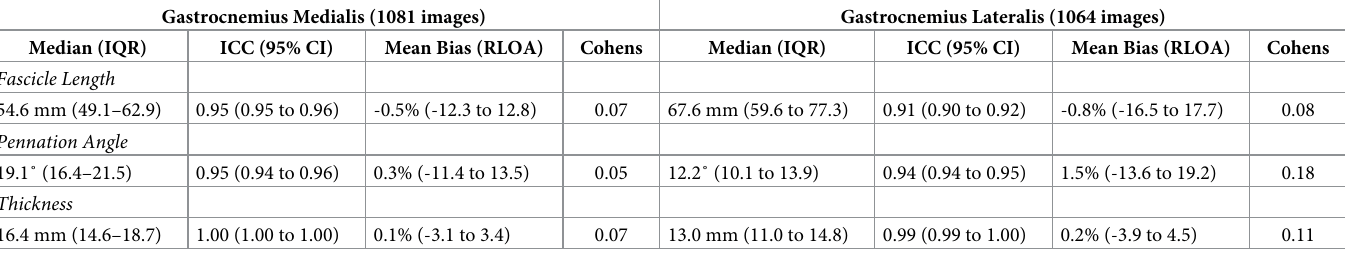
Table 1. Gastrocnemius medialis and gastrocnemius lateralis median (IQR) values and inter-rater reliability results for fascicle length, pennation angle and muscle thickness lengths. Gastrocnemius Medialis (1081